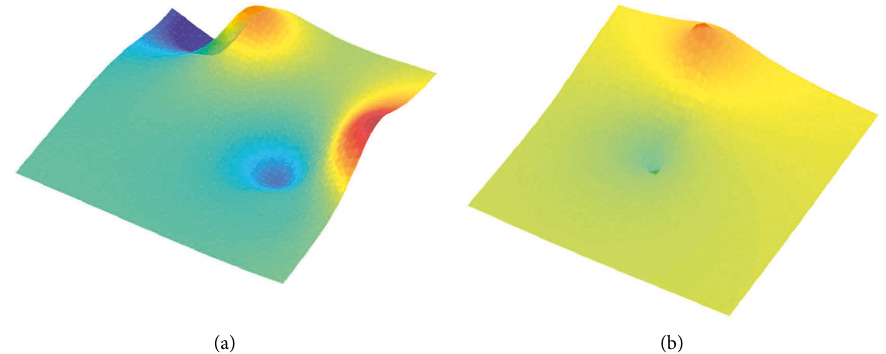
Figure 1: An example of a true utility function and a specific agent’s individual utility function. (a) A given 2-dimension problem space (i.e., a true utility function). (b) An agent’s individual representation of (a) (i.e., an individual utility function).